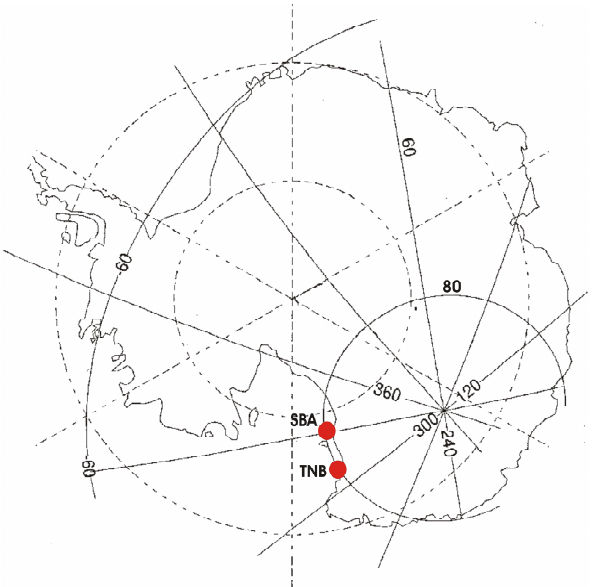
Fig. 1. Location of the two Antarctic bases TNB and SBA. The geographic and the corrected geomagnetic coordinate systems are indicated, as dashed and solid lines,